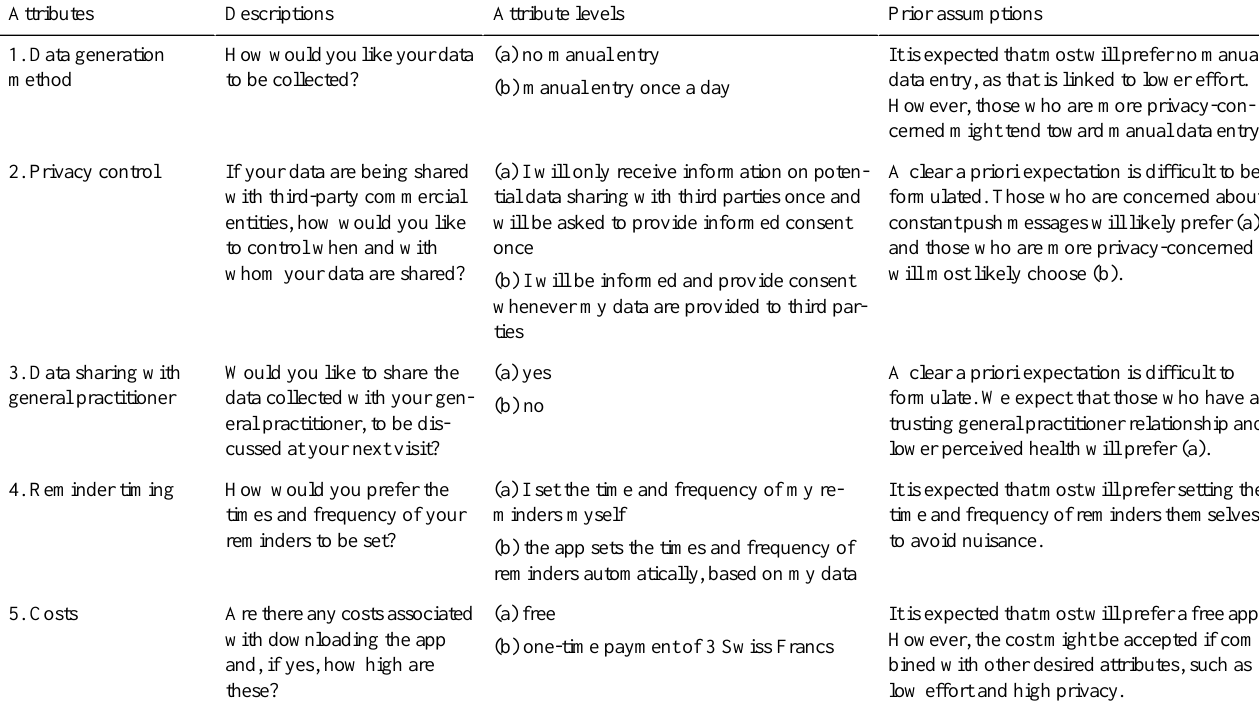
Table 1. Identified attributes, attribute levels, and prior assumptions.